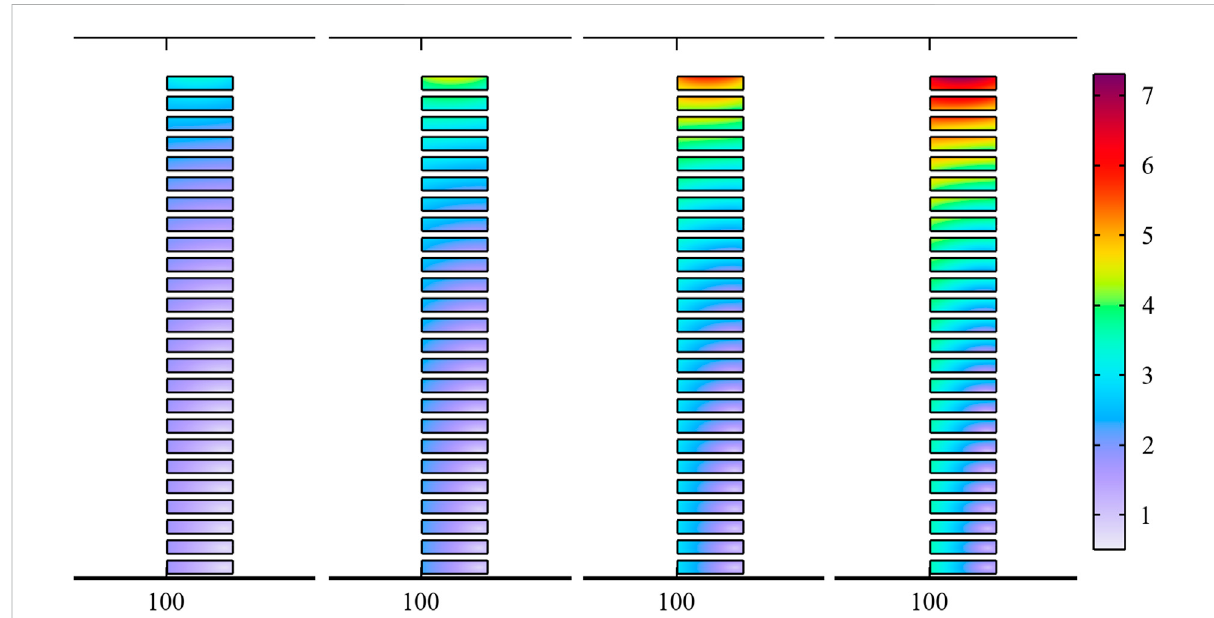
FIGURE 6 The J / J c distribution of solenoid magnet with rectangular cross-section while the carried current is 100, 120, 140 and 160